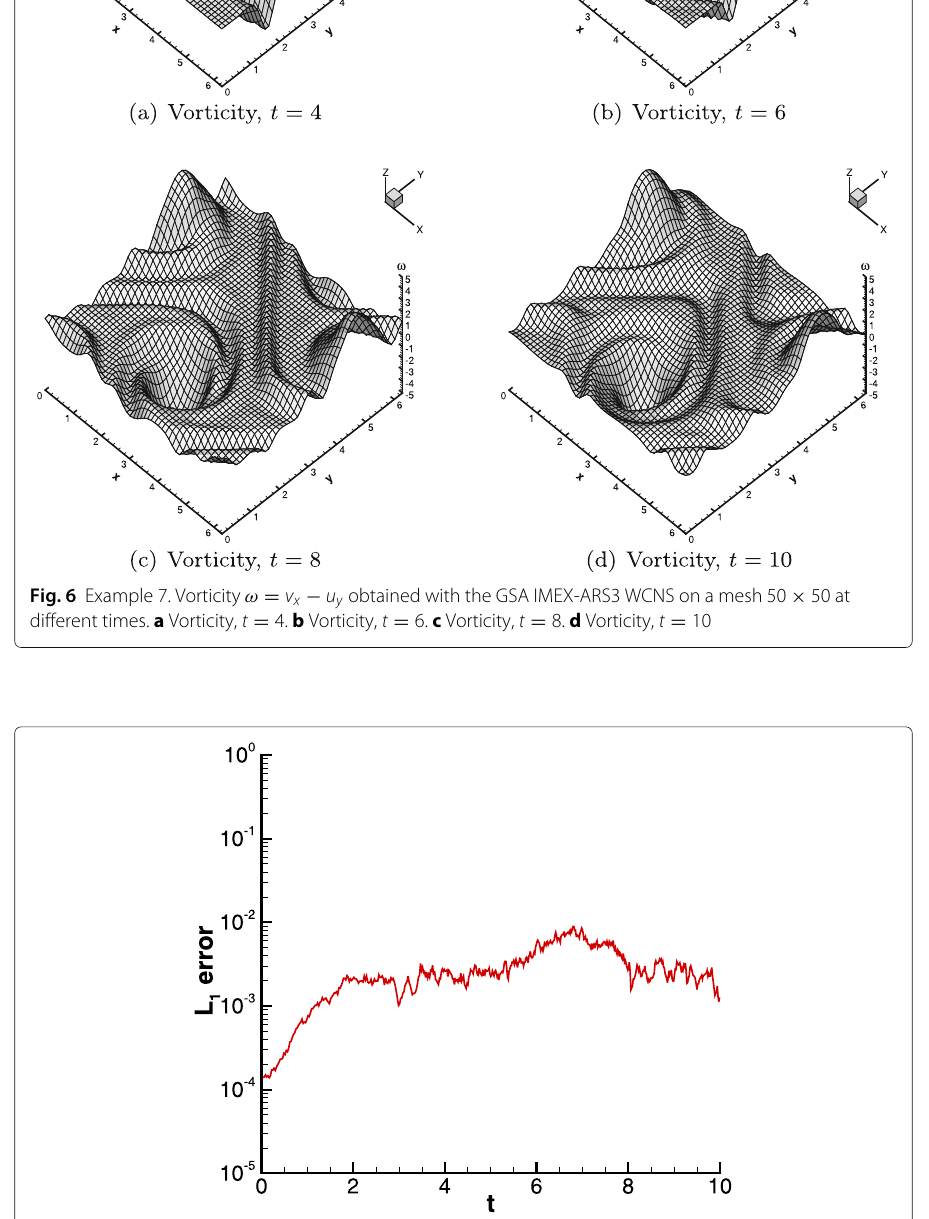
Fig. 7 Example 7. Time history of L 1 error of the divergence of the velocity ∇ ·